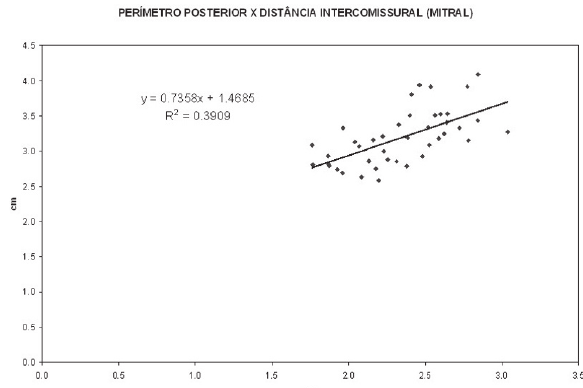
Fig. 2 - Perímetro do anel posterior versus distância intercomissural na valva mitral com equação obtida por ajuste de mínimos